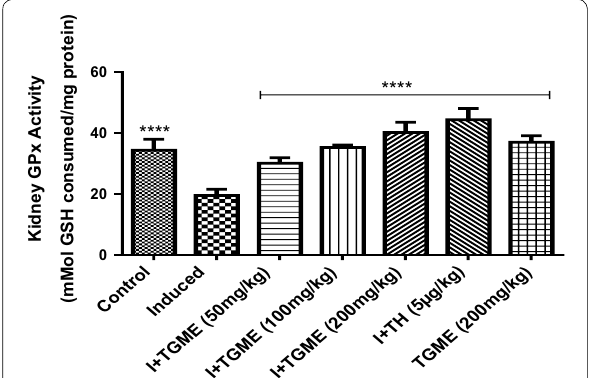
Fig. 13 Effect of aqueous methanolic leaf extract of Triclisia gilletii on SEM of 6 rats ( n 6); ± = GPx activity in the kidney of animals administered ethane-1,2-diol. Data are expressed as mean SEM of 6 rats ( n 6); * p < 0.05, ± = ** p < 0.01, *** p < 0.001, and **** p < 0.0001; *denotes that data were compared with ethane-1,2-diol; TGME Triclisia gilletii aqueous methanolic extract, TH tamsulosin hydrochloride, GPx glutathione peroxidase